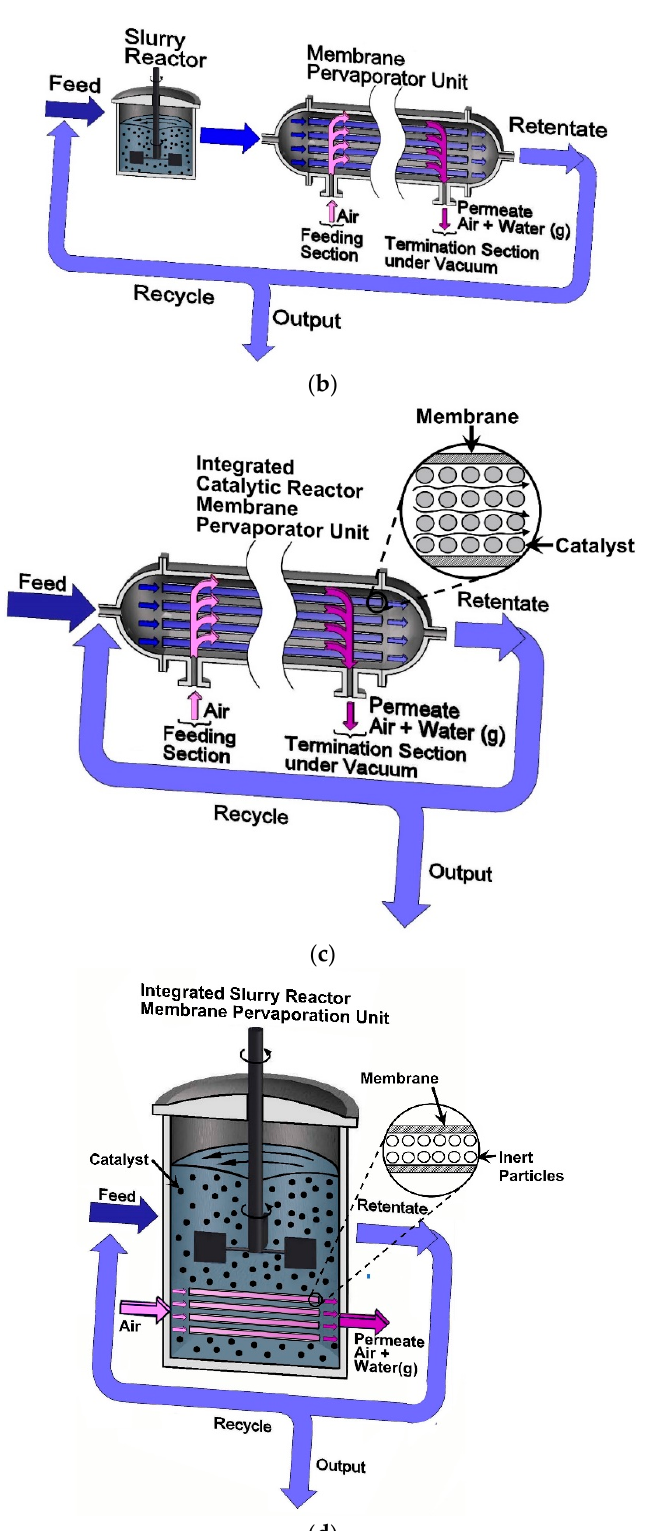
Figure 2. 3D Schematic description of the configurations of the four membrane reactors considered. ( a ) Configuration 1 : a FBR+PVMU (Fixed Bed Reactor and Pervaporation Membrane Unit), ( b ) Configuration 2 : a SR+PVMU (Slurry Reactor and Pervaporation Membrane Unit), ( c ) Configuration 3 : a IFBPVMR (Integrated Fixed Bed and Pervaporation Membrane Reactor), ( d ) Configuration 4 : a ISPVMR (Integrated Slurry and Pervaporation Membrane